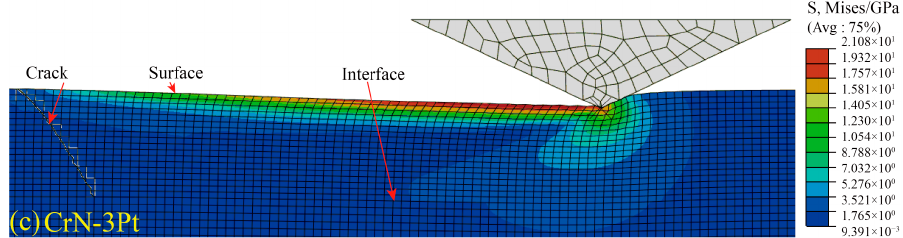
Figure 2. Stress nephogram of three kinds of coating cracks when penetrating the interface between